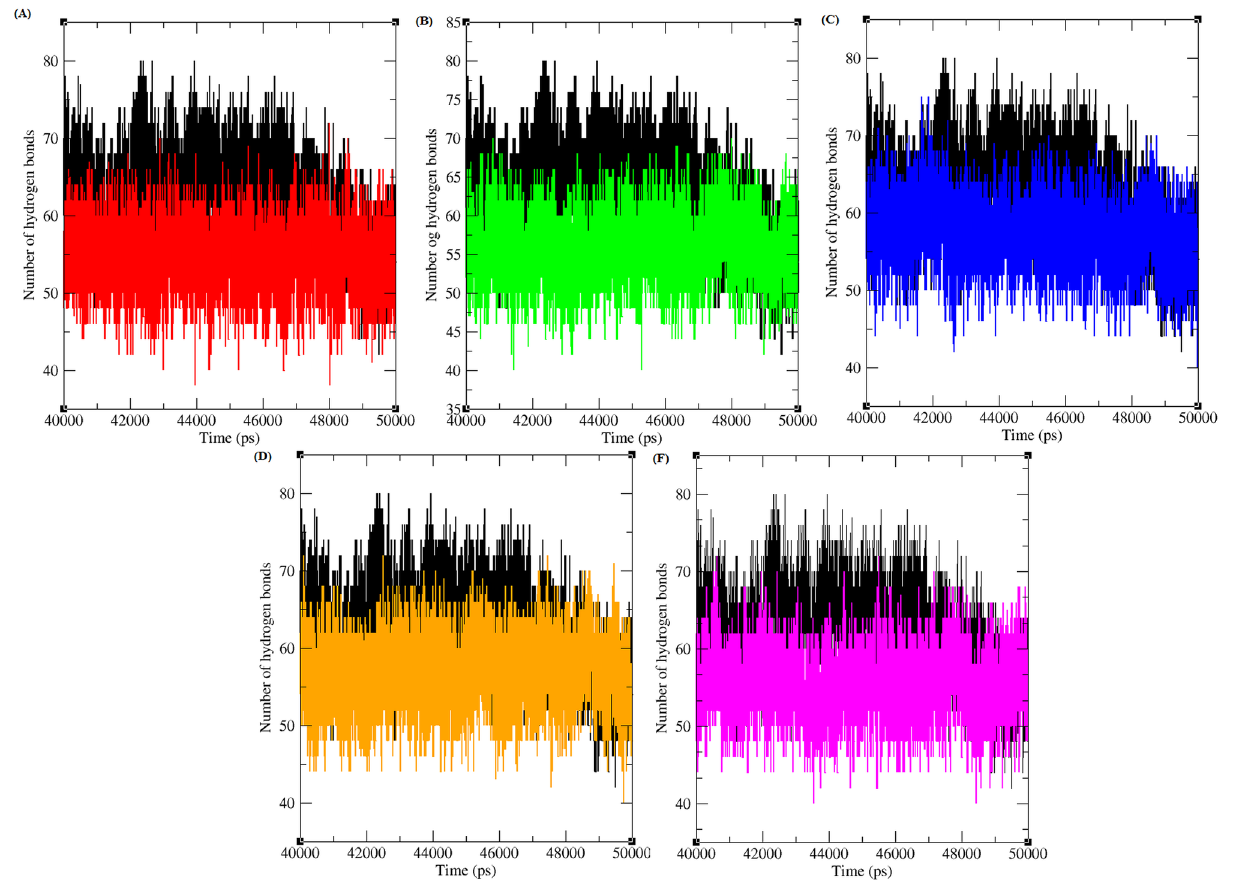
Fig 3. Total number of hydrogen bond formed between CDK4 and cyclin D1 protein in native and mutant state. Black, Red, Green, Blue, Orange and Pink lines indicate native, R24C, Y180H, A205T, R210P and R246C protein complexes respectively.